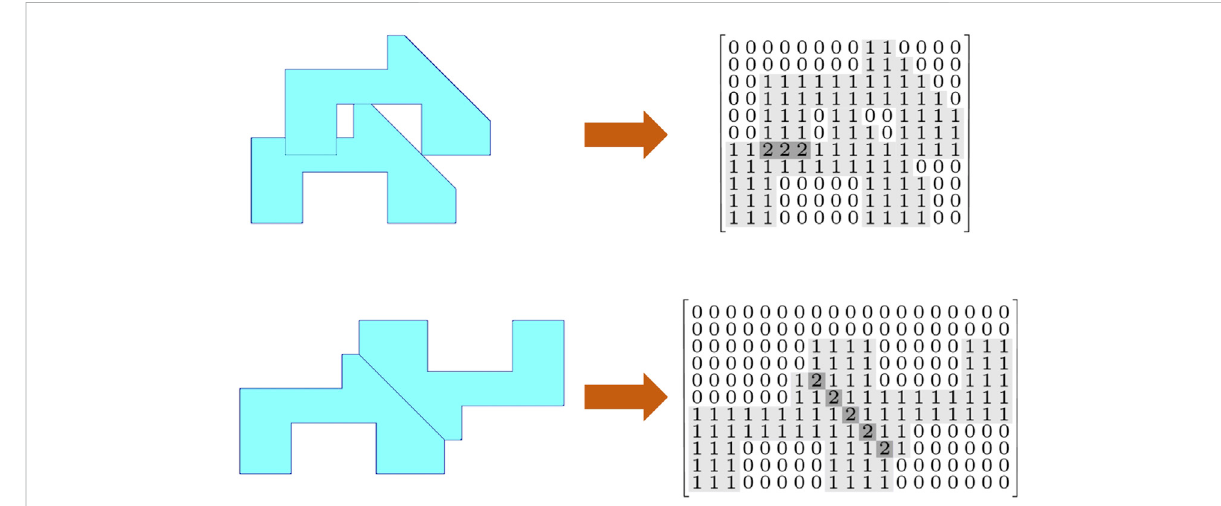
FIGURE 8 The pixel (or raster)